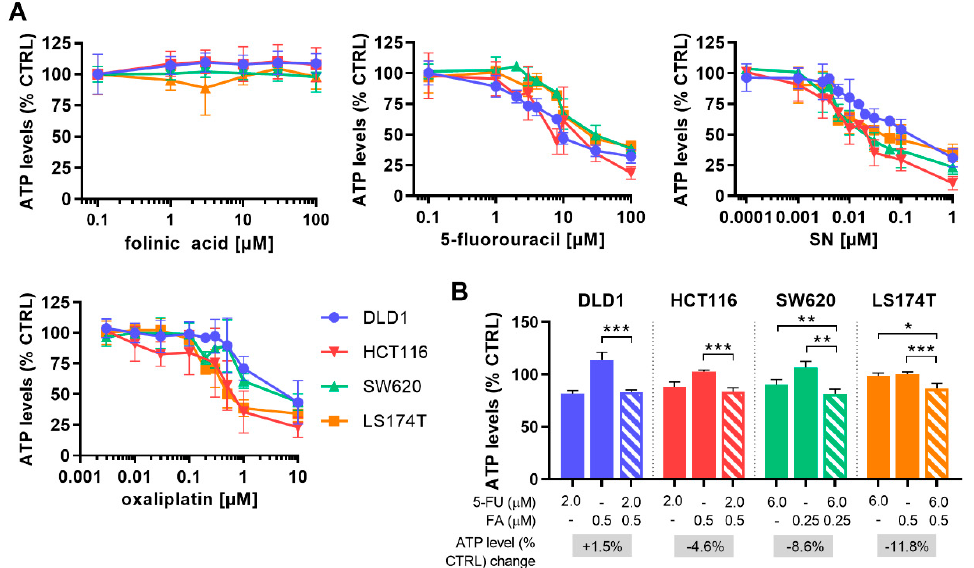
Figure 2. Drug dose-response curves for folinic acid, 5-fluorouracil, SN and oxaliplatin and the optimization of combining folinic acid and 5-fluorouracil. ( A ) Drug response curves of folinic acid (FA), 5-fluorouracil (5-FU), SN-38 (SN) and oxaliplatin (OX) in all CRC cell lines presented on a logarithmic scale. Cells were treated for 72 h. ( B ). Drug dose optimized for FA and 5-FU towards the combined activity of 20% on cell metabolic activity (ATP) inhibition after 72 h treatment. The increase in cell metabolic activity inhibition of the FA / 5-FU (FF) combination compared to 5-FU alone is indicated in the grey box. Error bars represent the SD for N = 2–6 experiments ( A ) or N = 3 experiments ( B ) and significances of * p < 0.05, ** p < 0.01 and *** p < 0.001 represent the comparison of single drugs with FA and 5-FU combined as determined by a two-way ANOVA with post-hoc Dunnett’s multiple comparisons test.